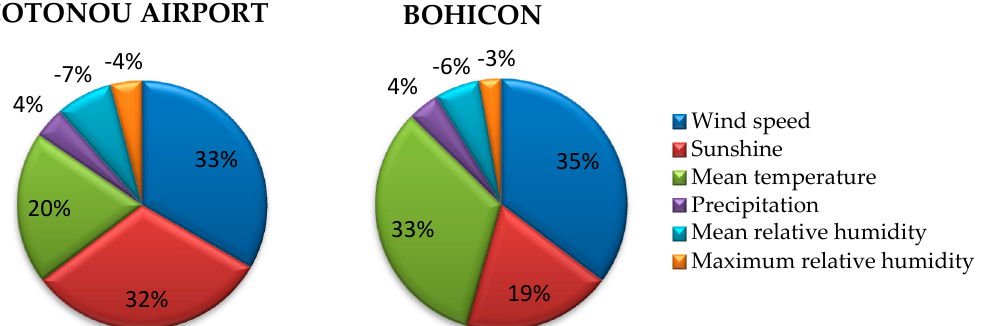
Figure 5. Plot of the percentage of pan evaporation variance hold in each of its explanatory variables.